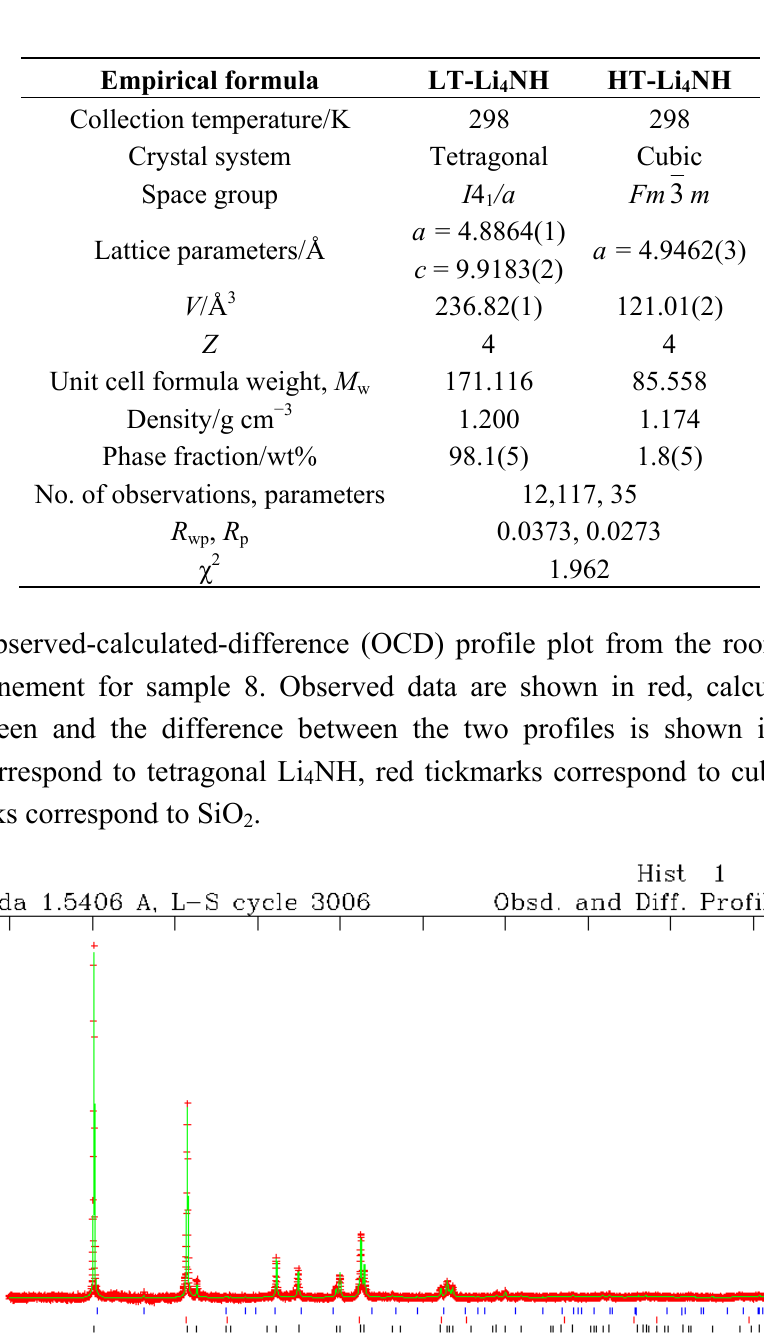
Table 3. Selected Rietveld refinement data from the lab X-ray refinement of sample 8 at 298 K.